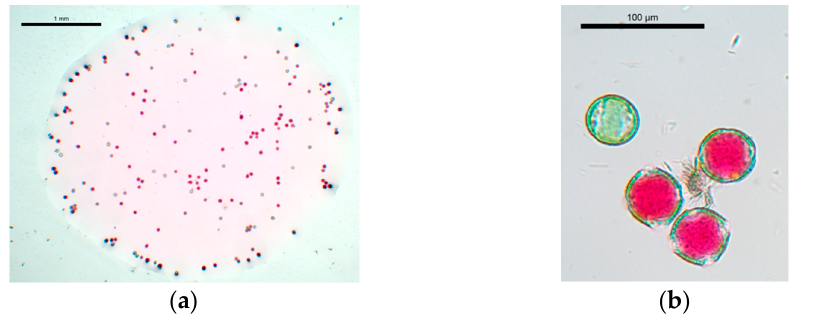
Figure 5. ( a ) Example of a 0.3 µL drop with pollen grains dispersed in the staining solution. ( b ) Detail of viable pollen grains stained magenta-red, and non-viable pollen grains stained blue-green.